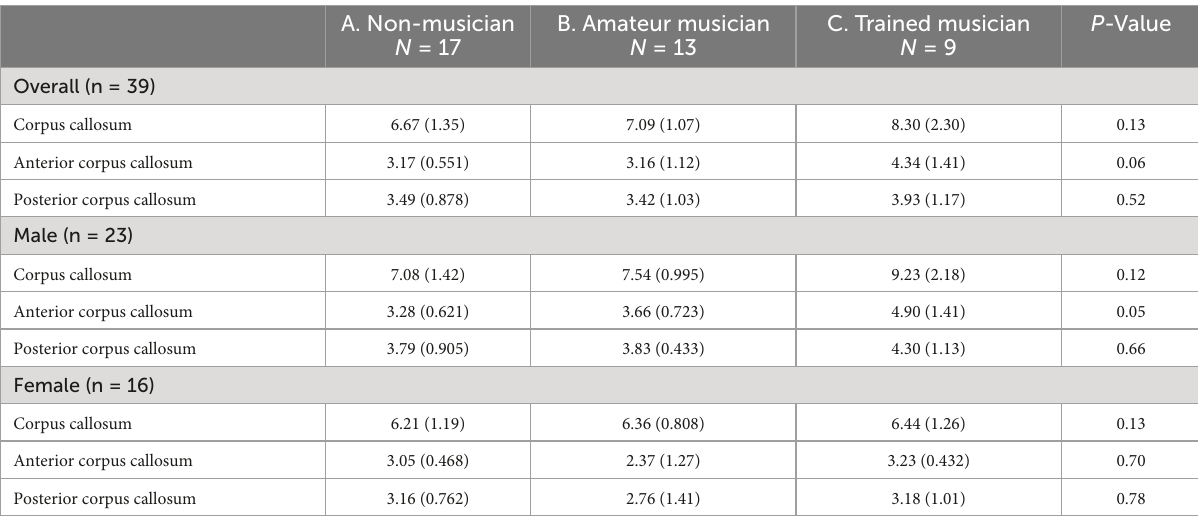
TABLE 3 Corpus callosum measurements vs.